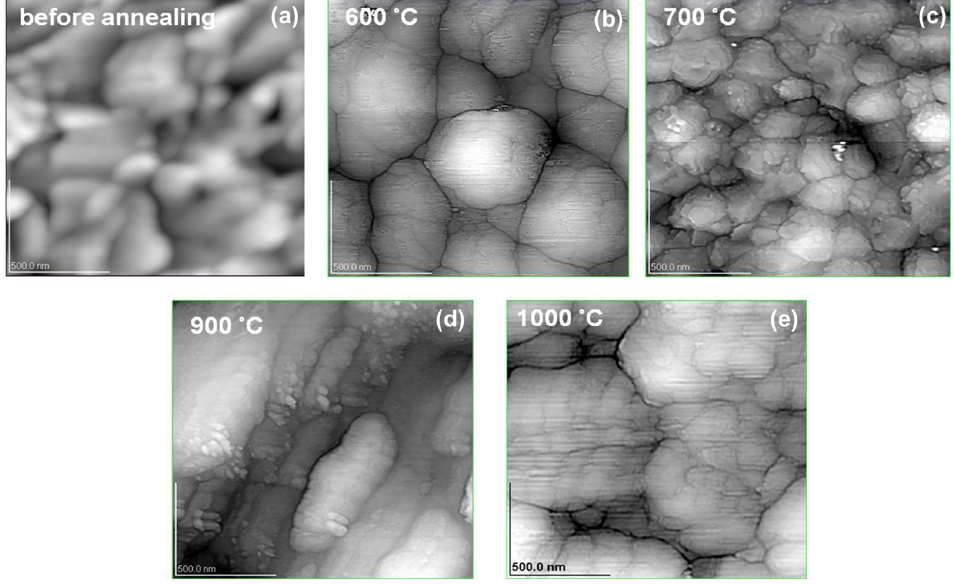
Figure 4. AFM image of the Ti–Al samples after Si + implantation during heat treatment: ( a ) before annealing; ( b ) 600 °C; ( c ) 700 °C; ( d ) 900 °C; ( e ) 1000 °C.